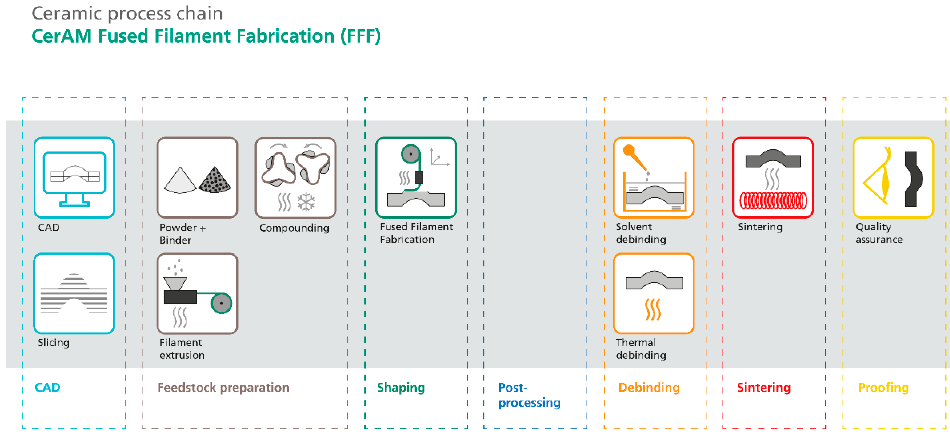
Figure 2. Overview about the process chain of CerAM FFF.